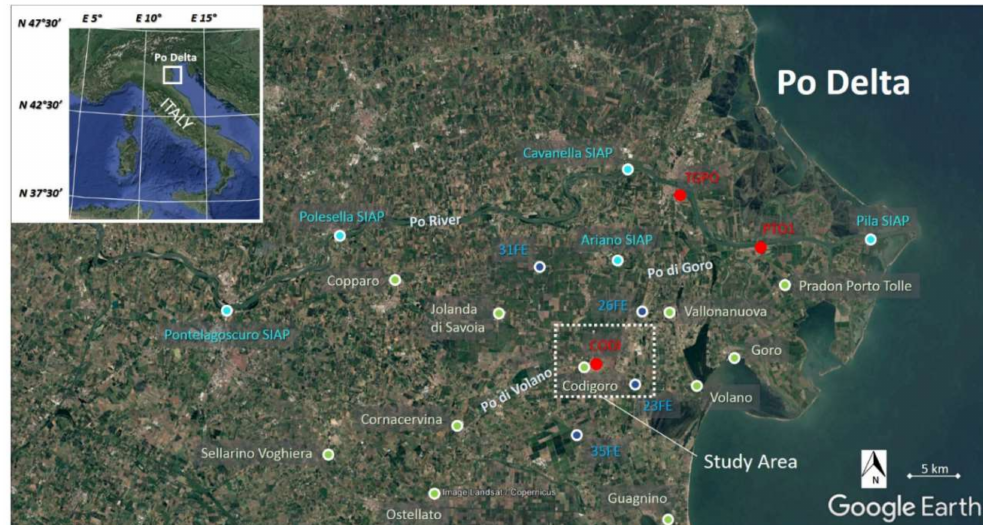
Figure 3. Codigoro area location map: continuous GPS sites (red dots), river hydrometric stations (cyan dots), pluviometric stations (light green dots), and piezometers (light blue